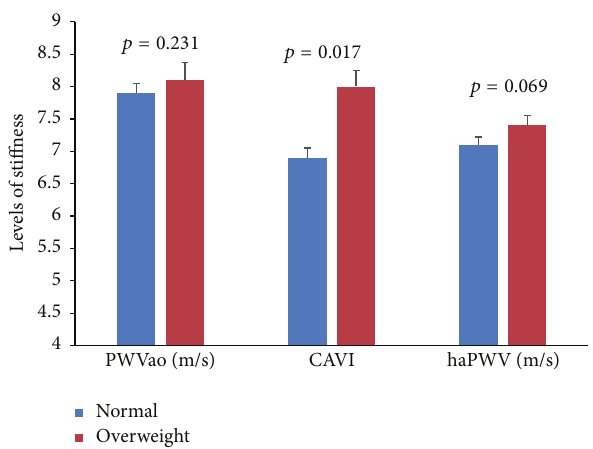
Figure 2: Comparison of arterial stiffness indices between nonhy- pertensive and prehypertensive